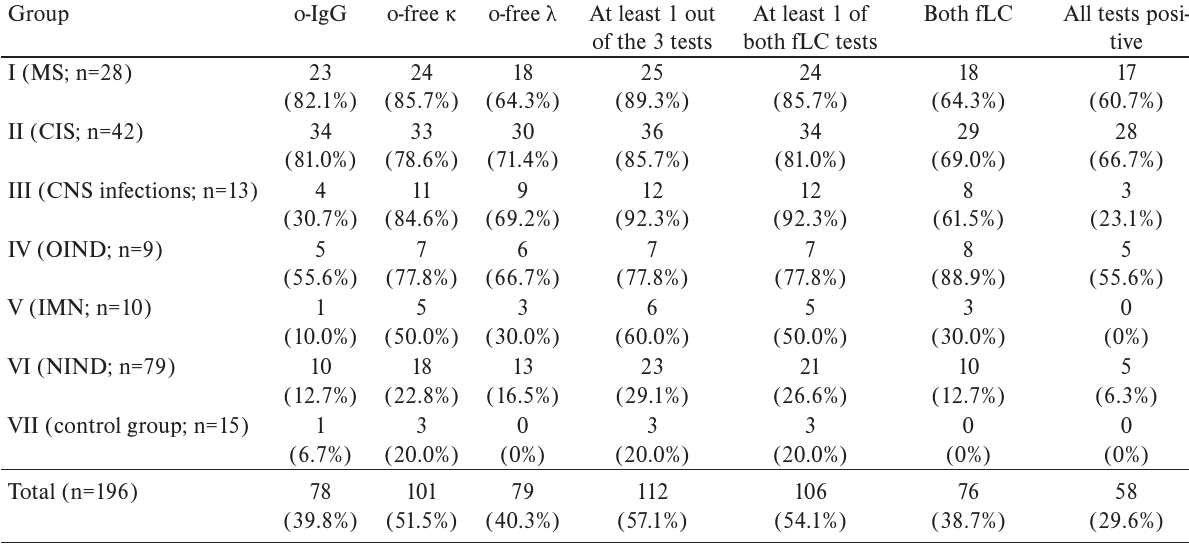
Table 1. Proportion of patients positive for o-IgG, o-free κ and o-free λ in individual disease groups, using conventional criterion of ≥2 CSF-restricted